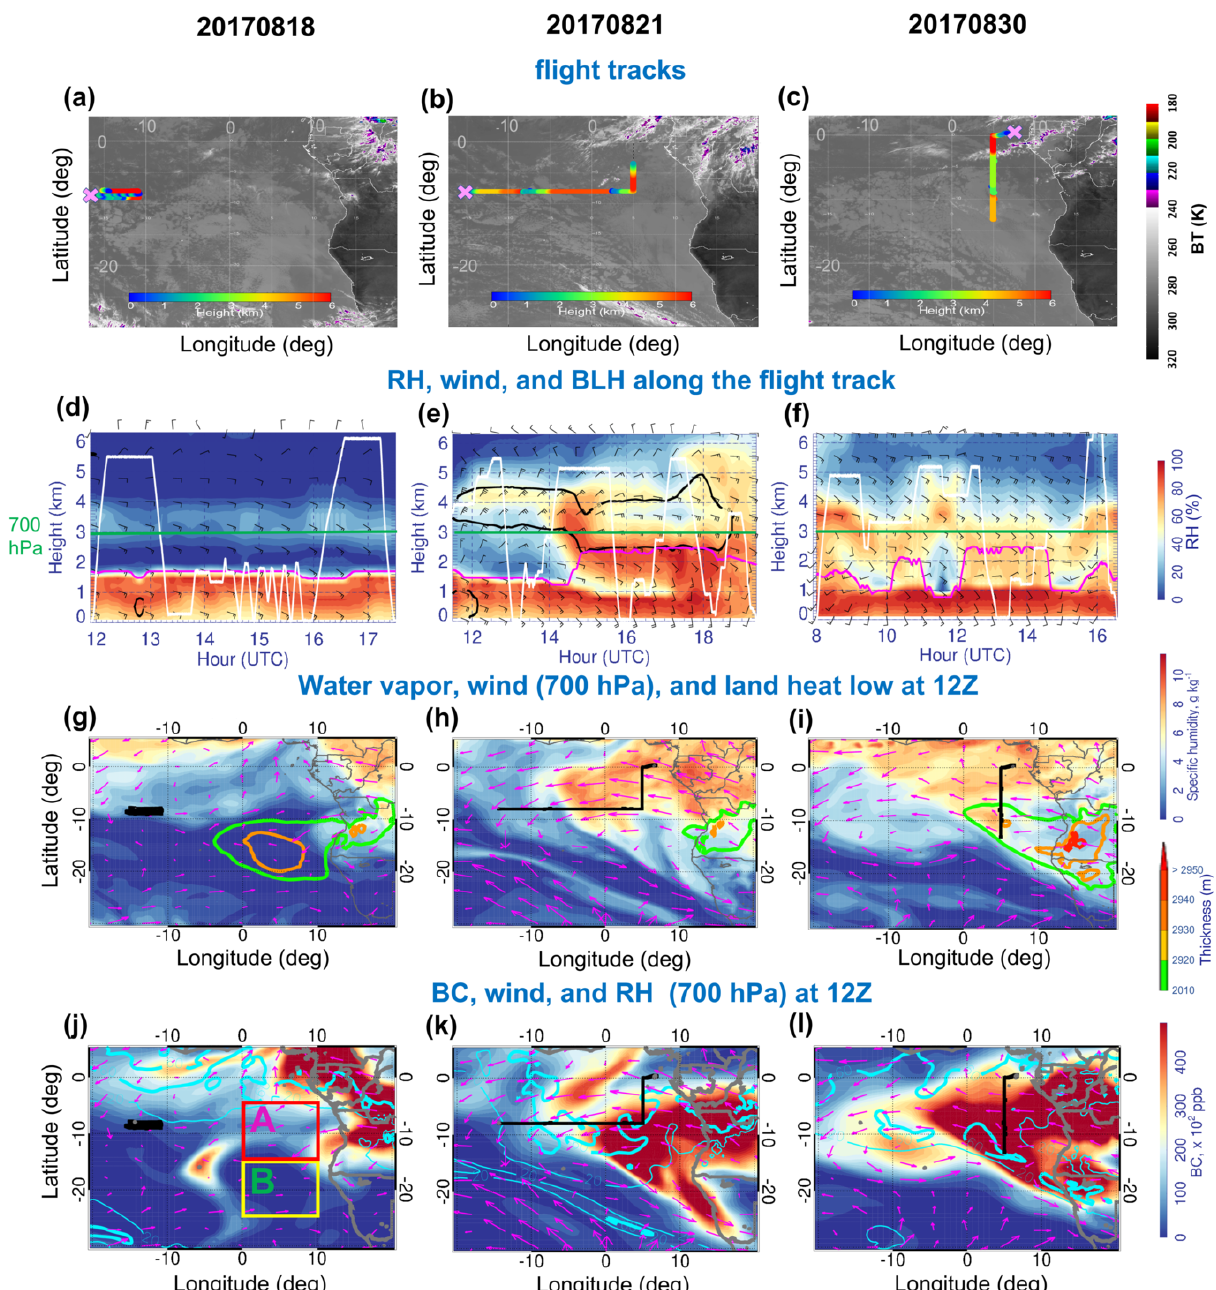
Figure 8. (a–c) The horizontal flight tracks during the August 2017 ORACLES deployment plotted on Meteosat IR 10.8µm imagery at 13:45UTC (shading is the brightness temperature (BT); K). The color of the flight track represents the altitude of the P-3 flight along the horizontal flight track. (d–f) Curtain plot of RH along the P-3 flight track during 18, 21, and 30 August 2016. The white contour represents the flight profile. The magenta line in panels (d) – (f) represents the BLH along the flight track. Bold black contours in panels (d) – (f) are zonal winds ( − 8ms − 1 ). The green line in panels (d) – (f) indicates the 700hPa level. (g–i) Map of 700hPa q (color shading; gkg − 1 ) and 700hPa horizontal winds (vectors; ms − 1 ) overlaid by thickness (thickness is the geopotential height ( Z ) difference between 600 and 850hPa; color line contour; high values ( > 2920m) over land represent the heat low) at 12:00UTC on 18, 21, and 30 August 2017, respectively. (j–l) Map of 700hPa BC (shading; ppb × 100) overlaid by 700hPa RH (thick cyan line is 60; thin cyan line is 20; %) and 700hPa horizontal winds (vectors; ms − 1 ) at 12:00UTC 18, 21, and 30 August 2017. The black line in panels (g) – (l) represents the horizontal flight track on the given day. The magenta (yellow) box in panel (j) refers to region A at 0–10 ◦ E, 5–15 ◦ S (region B at 0–10 ◦ E, 15–25 ◦ S).